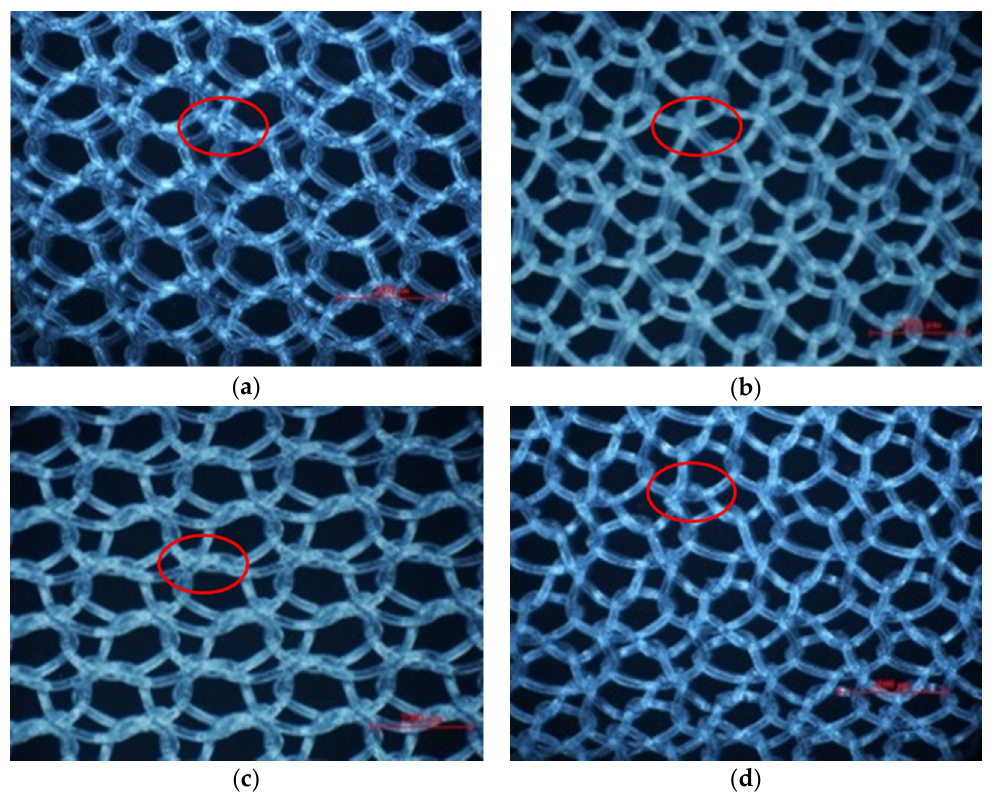
Figure 2. Differences in open loops of the same lapping structures shown in red circles. ( a ) Device No. 3; ( b ) Device No. 6 ‐ 1; ( c ) Device No. 6 ‐ 2; ( d ) Device No. 7.